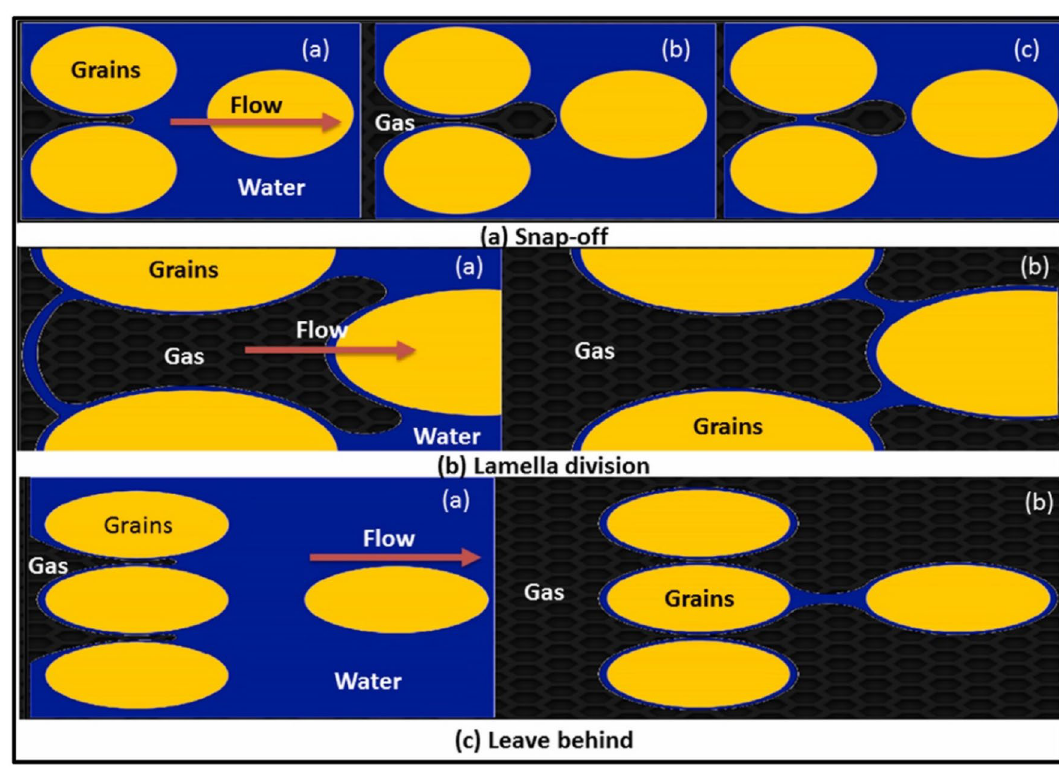
Fig. 5 Foam generation through porous media. (Almajid and Kovscek